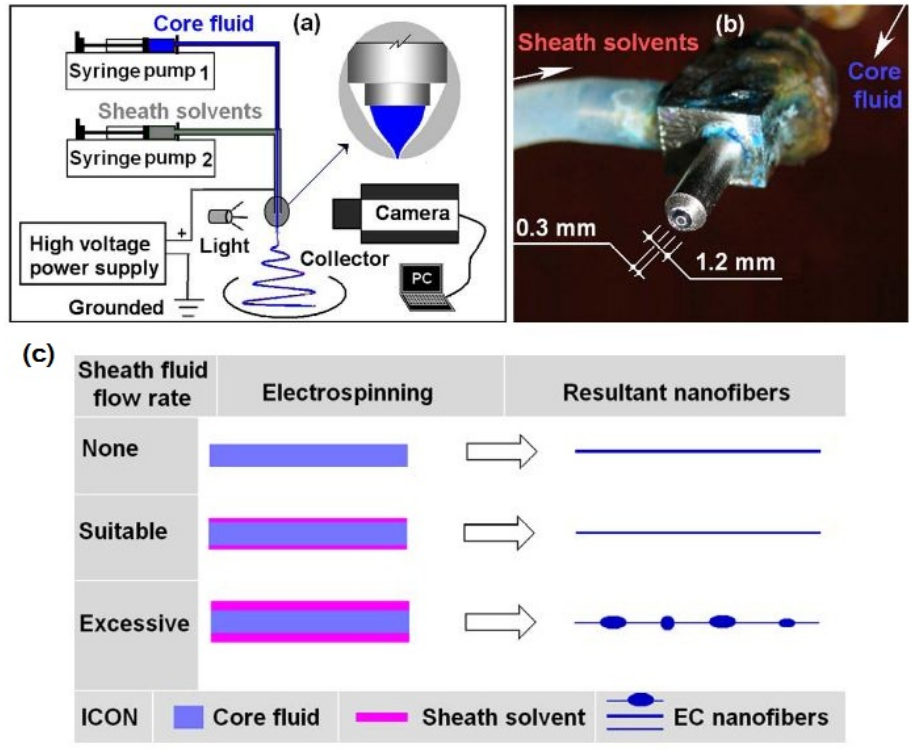
Figure 18. ( a ) Schematic diagram of modified coaxial electrospinning; ( b ) photograph of homemade concentric spinneret and ( c ) the proposed mechanism of nanofibers formation using sheath solvent in coaxial electrospinning (reprinted from reference [171]).